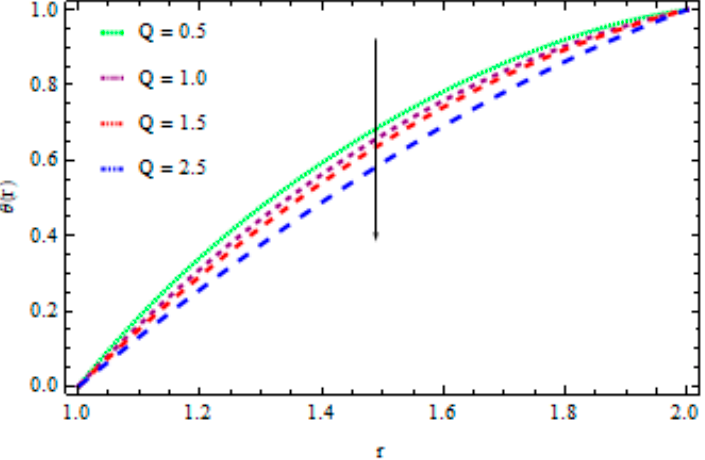
Figure 11. The influence of